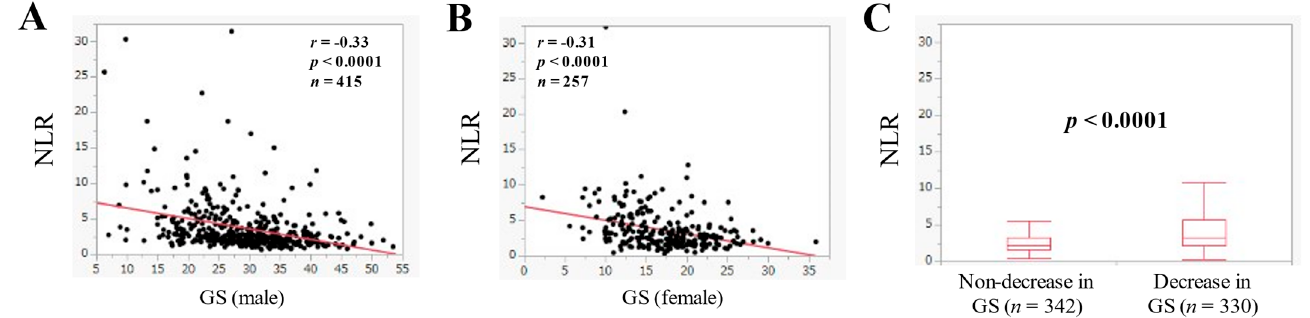
Figure 6. The correlation in the NLR and grip strength (GS) in male (( A ), n = 415) and female (( B ), n = 257). ( C ) Comparison of NLR in patients with non-decrease in GS ( n = 342) and decrease in GS ( n = 330).